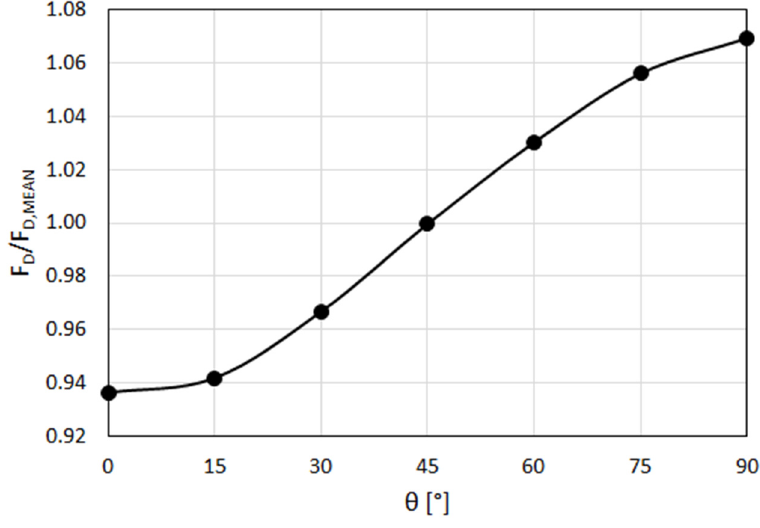
Figure 9. Variation of drag force with varying relative orientation (TRI).